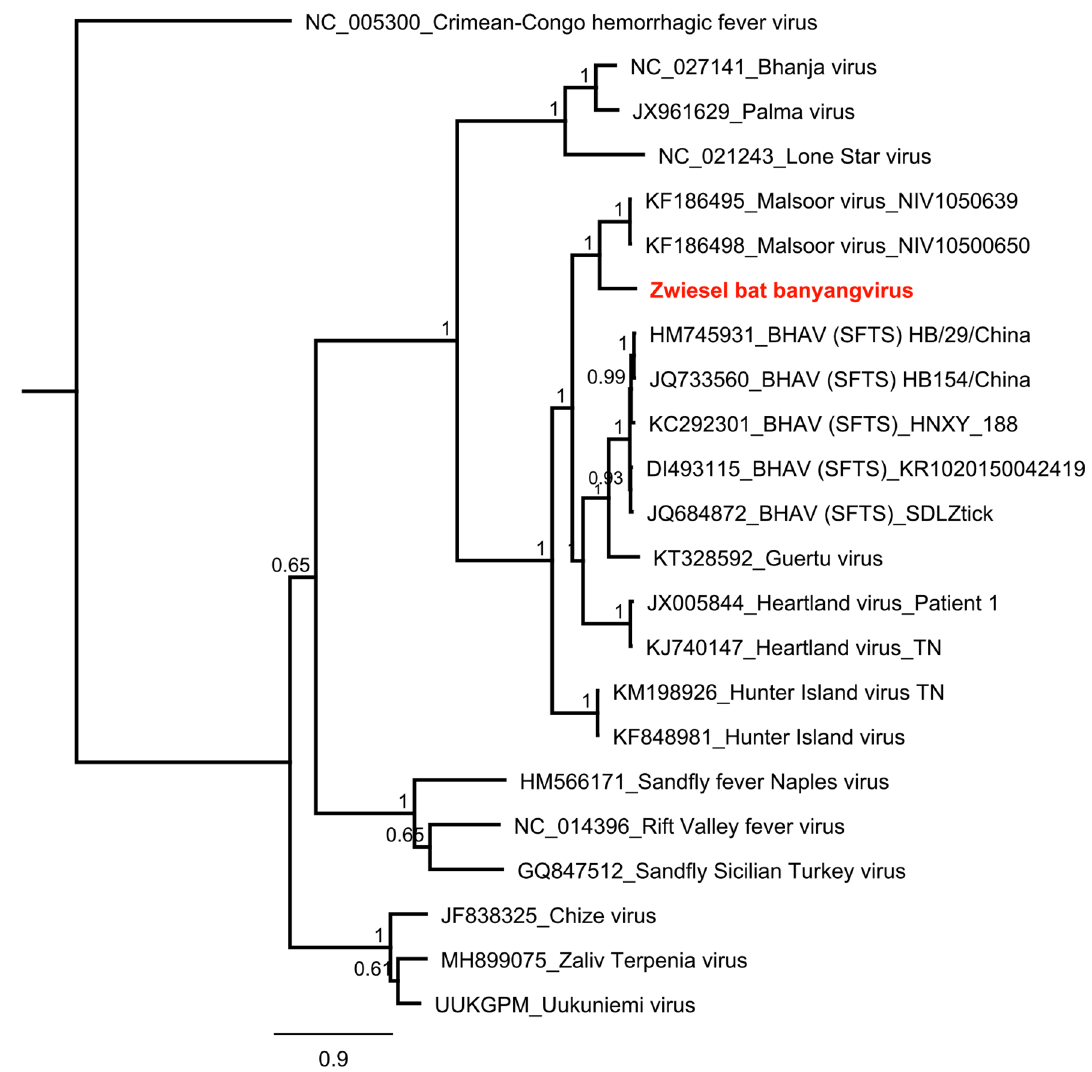
Figure 7. Phylogenetic reconstruction of Phenuiviruses glycoprotein–ML, 1 million, 2578 nt. Reconstruction was performed via the Bayesian MCMC approach using MrBayes with the following settings (burn-in, 30%; frequency, 100; chain length, 1 million to 10 million, depending on when a standard derivation of below 0.025 was reached) 78 . Reconstructed trees were visualized using FigTree and posterior probabilities were depicted for each node (http:// tree. bio. ed. ac. uk/ softw are/ figtr